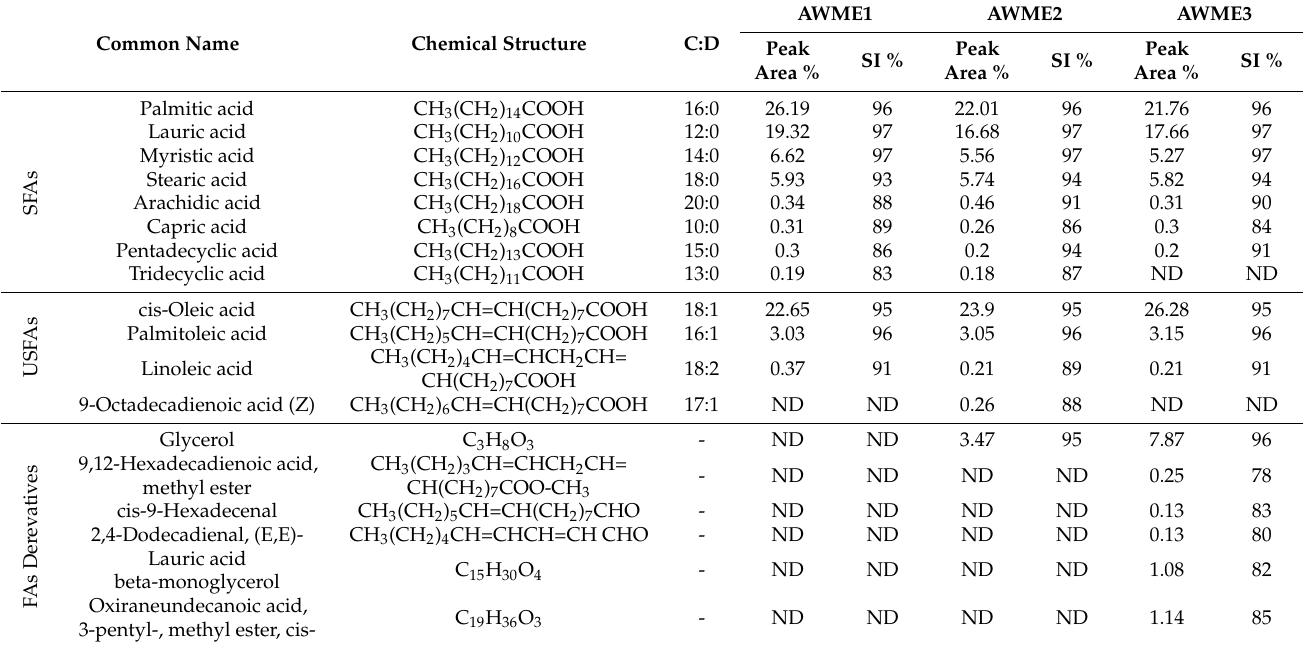
Table 4. Major compounds of various SEs of BSFL fat detected by